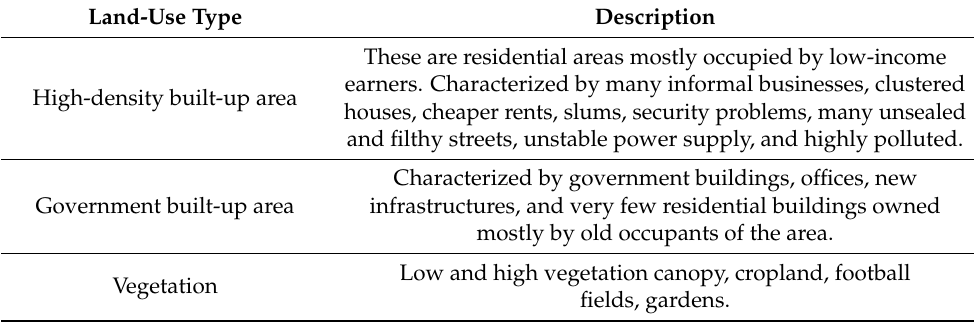
Table 2. Cont. Land-Use